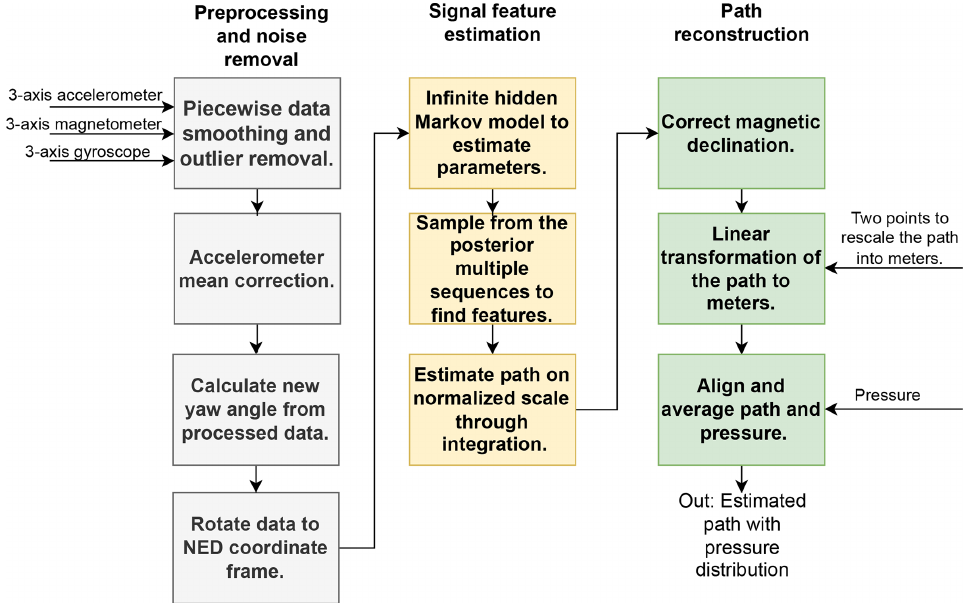
Figure 4. Workflow diagram of the processing sequence. The model applies an infinite hidden Markov model (iHMM; see Beal et al., 2002) on the IMU data to detect signal features. NED stands for